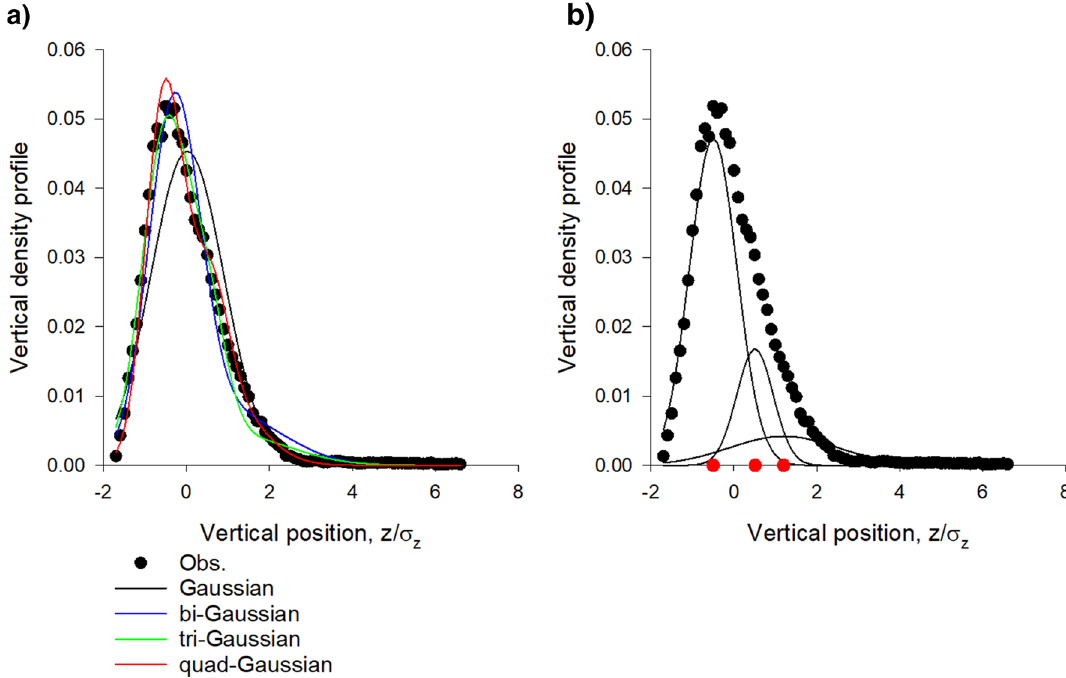
Figure 2. ( a ). Vertical density profiles of laboratory swarms are accurately represented by superpositions of Gaussians. ( b ) Constituent Gaussians in the tri-Gaussian representation with centres at •. In accordance with observations, the best superpositions “ contains around 3 horizontal layers, with the lowest layer being flattered than the others” [van der Vaart, Private Communication]. The Akaike weights for the single-, bi-, tri- and quad- Gaussian fits are 0.00, 0.78, 0.21 and 0.01 indicating strong support for the bi and tri-Gaussian representations. Data are taken from Sinhuber et al. 14 : swarm Ob5 which contains on average 22 individuals. The swarm is centred on z = 0.